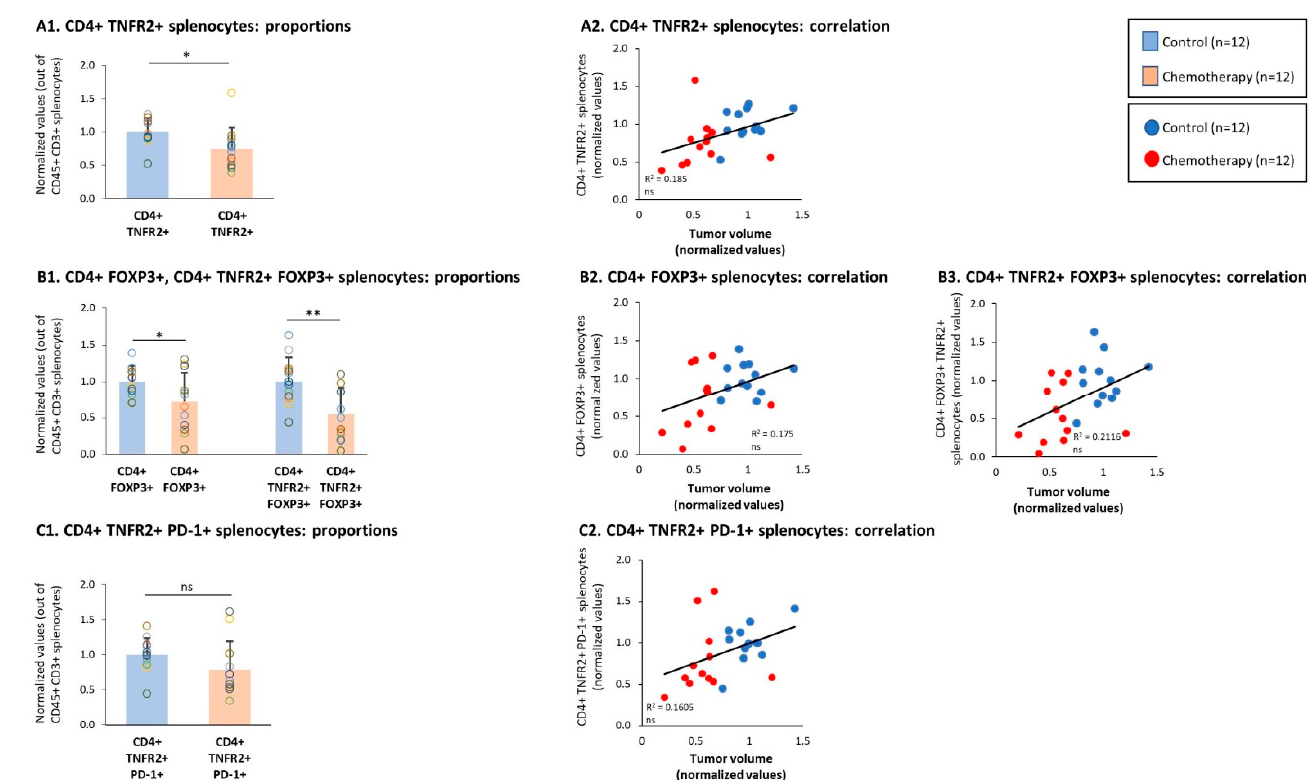
Figure 8. Chemotherapy reduced the proportions of CD4+ TNFR2+ FOXP3+ and CD4+ TNFR2+ PD-1+ splenocytes. Murine 4T1 TNBC cells were syngrafted to BALB/c mice in the presence of chemotherapy or a vehicle control; procedures and analyses were performed as described in Figure 3. ( A ) CD4+ TNFR2+ splenocytes, gated out of CD45+ CD3+ cells. ( A1 ) Proportions of CD4+ TNFR2+ splenocytes. ( A2 ) CD4+ TNFR2+ splenocytes, correlated with tumor volumes. ( B ) CD4+ FOXP3+ and CD4+ TNFR2+ FOXP3+ splenocytes, gated out of the CD45+ CD3+ cells. ( B1 ) Proportions of CD4+ FOXP3+ and CD4+ TNFR2+ FOXP3+ splenocytes. ( B2 , B3 ) CD4+ FOXP3+ and CD4+ TNFR2+ FOXP3+ splenocytes, respectively, correlated with tumor volumes. ( C ) CD4+ TNFR2+ PD-1+ splenocytes, gated out of the CD45+ CD3+ cells. ( C1 ) Proportions of CD4+ TNFR2+ PD-1+ splenocytes. ( C2 ) CD4+ TNFR2+ PD-1+ splenocytes, correlated with tumor volumes. In the proportion and correlation analyses, the average value of the vehicle-treated group in each biological repeat was given the value of 1 and the values of all mice analyzed in that repeat were normalized accordingly. The value of each mouse is presented as a dot. ** p < 0.01,* p < 0.05, ns: not significant (two-tailed unpaired Student’s t -test; correlation analyses: Pearson; T.DIST).